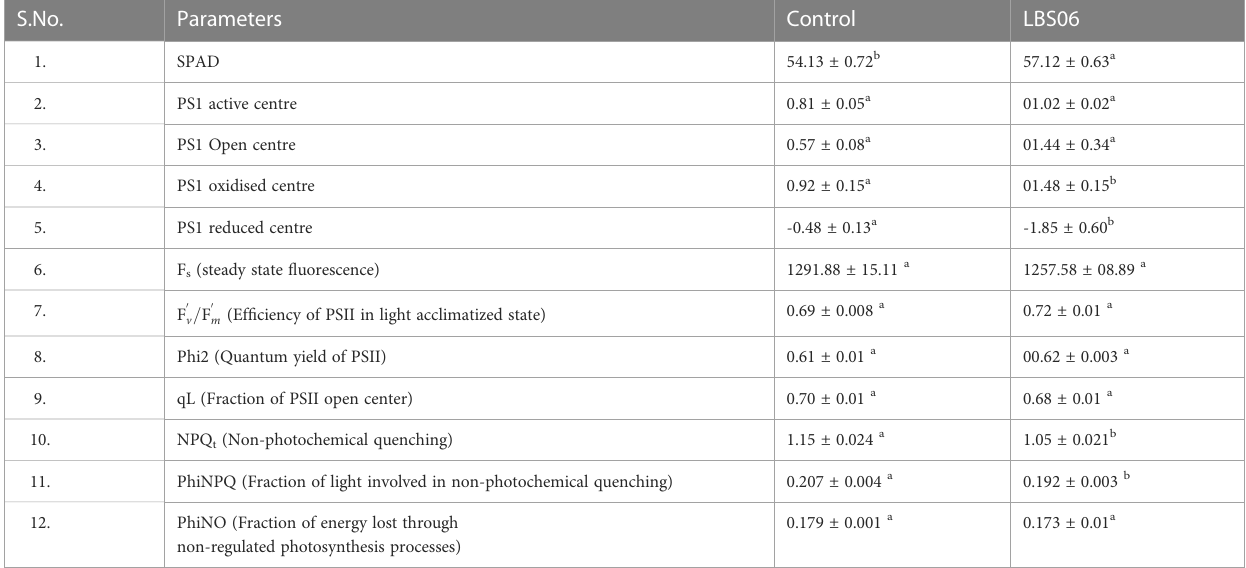
TABLE 1 Effect of LBS6 on the chlorophyll fl uorescence parameters from leaves of the cucumber plants.